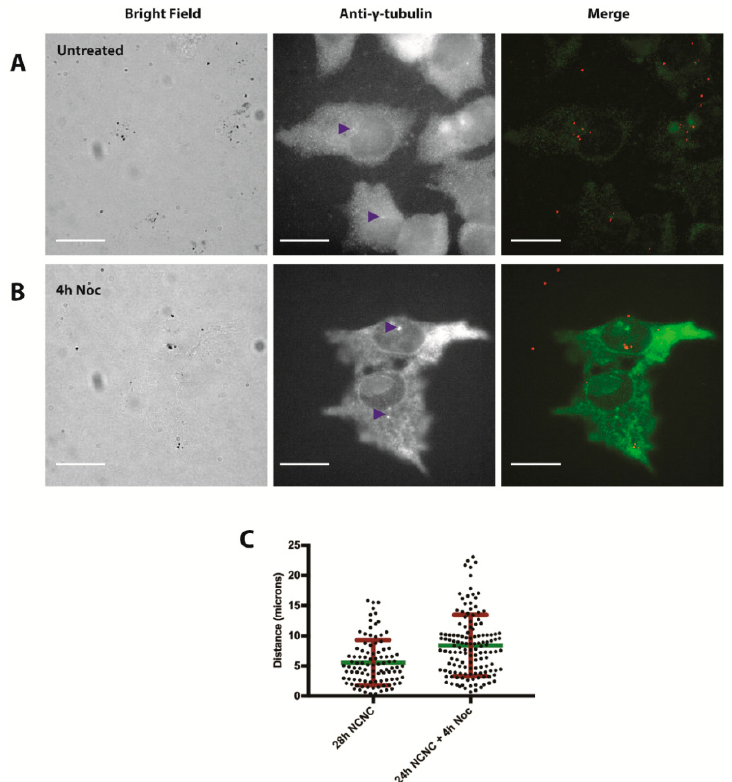
Figure 4. NCNC localization near centrosomes. ( A ) HeLa cells were incubated with 2 µ g / mL NCNC for 24 h, they were then washed and incubated for 4 h with fresh medium and were fixed and stained using antibodies against γ -tubulin. Blue arrowheads indicate location of centrosomes. Red puncta in merge image represents the NCNCs imaged in bright field. ( B ) HeLa cells were incubated with 2 µ g / mL NCNCs for 24 h, washed and incubated with the microtubule disruptor nocodazole for 4 h. The cells were then fixed and stained using antibodies against γ -tubulin. Blue arrowheads indicate the location of centrosomes. Red puncta in merge image represent the NCNCs imaged in bright field. ( C ) NCNC puncta distance was calculated using ImageJ software for cells in treatment groups from panels A and B. Green line indicates mean distance and red bars indicate standard deviation, n ≥ 100 puncta for each treatment group, t -test p value < 0.0001.